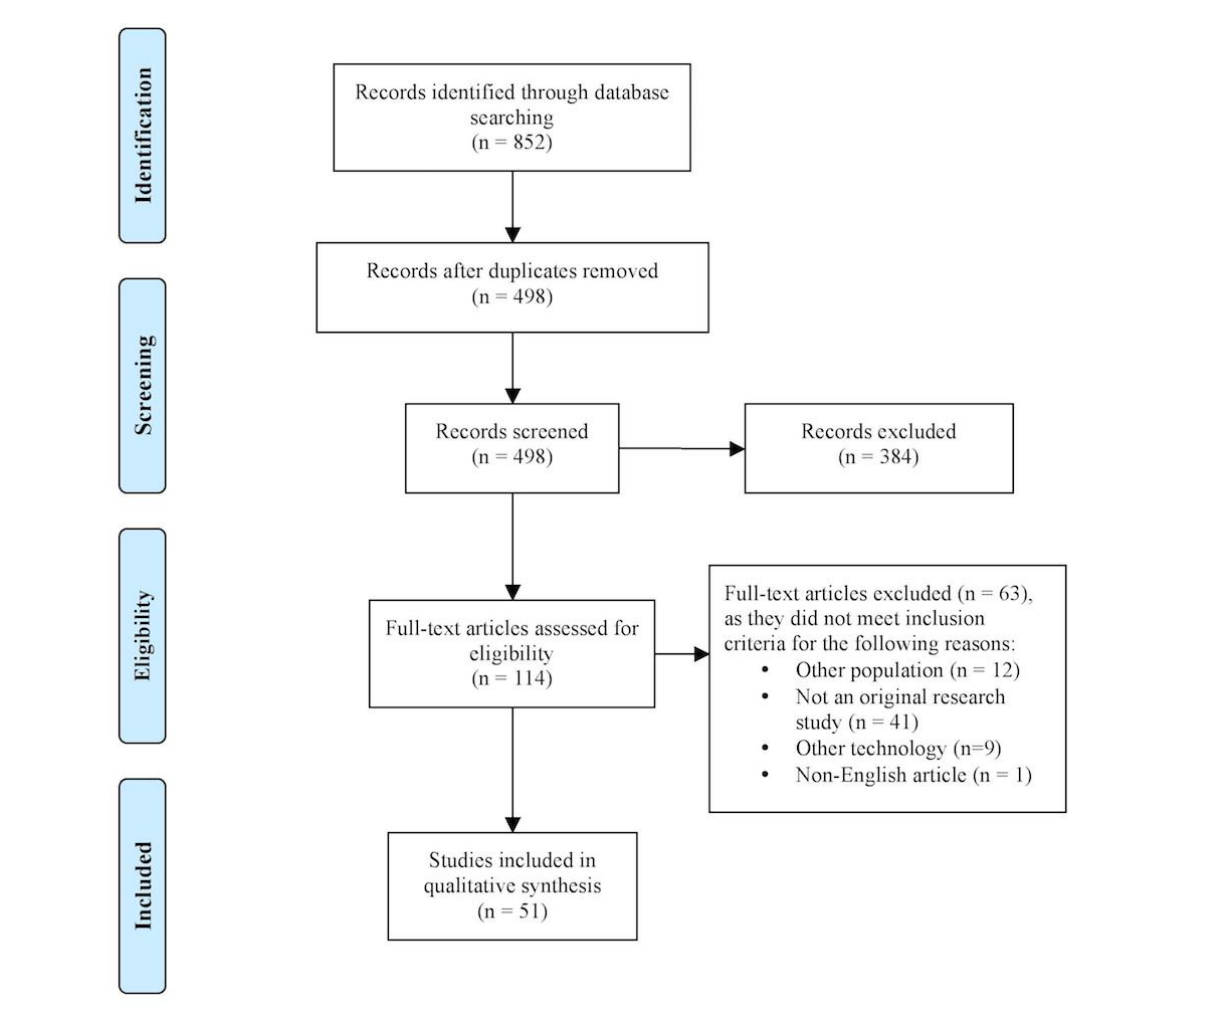
Figure 1. Flow of studies according to PRISMA